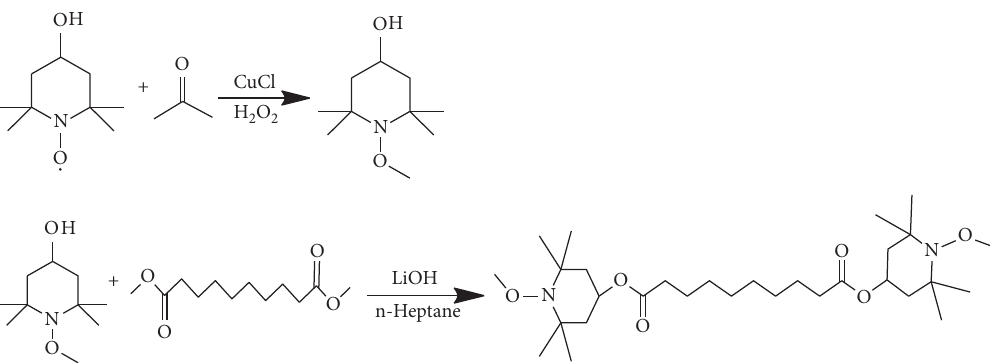
Scheme 1: Synthesis principle of